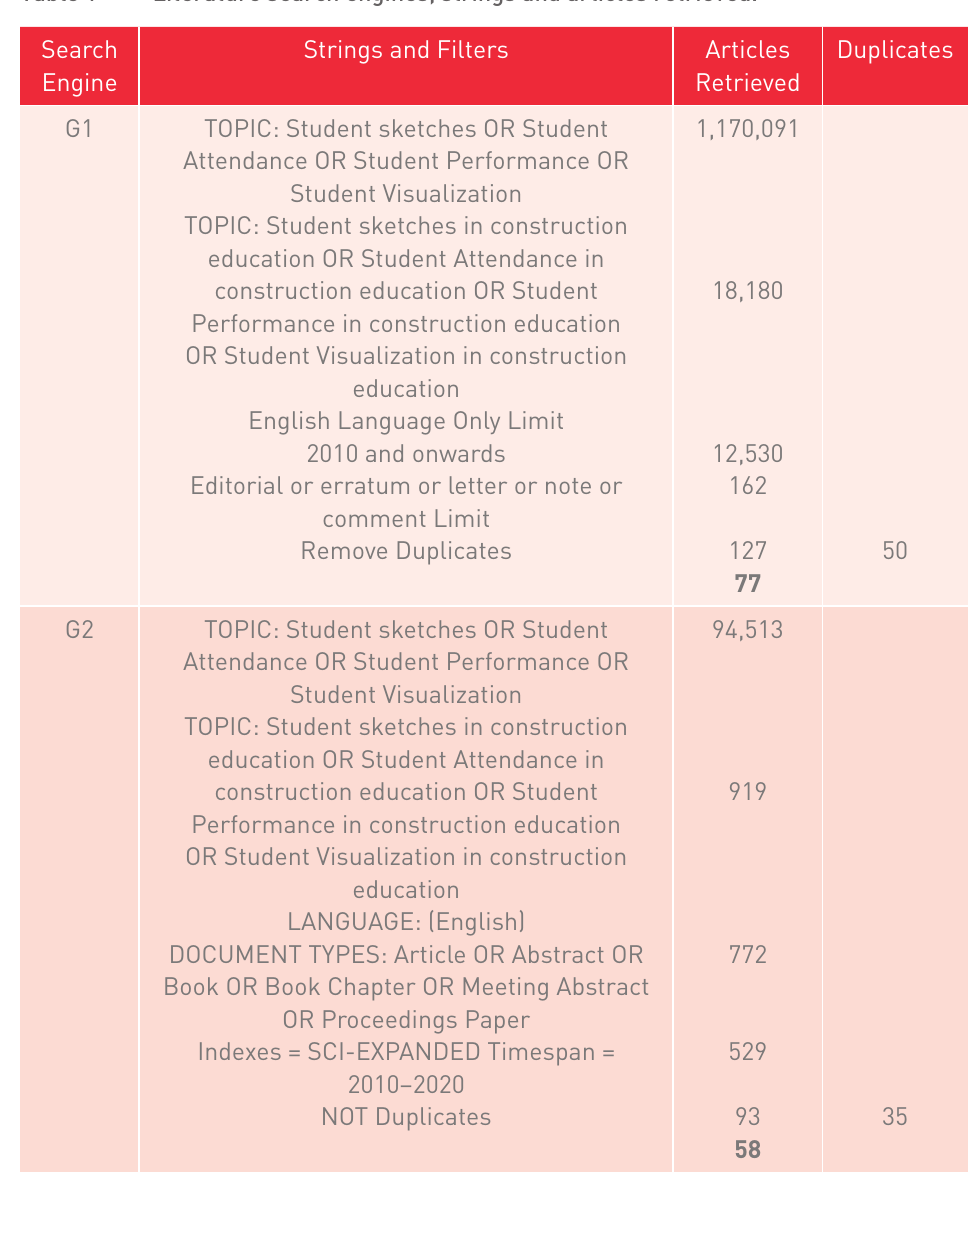
Literature search engines, strings and articles